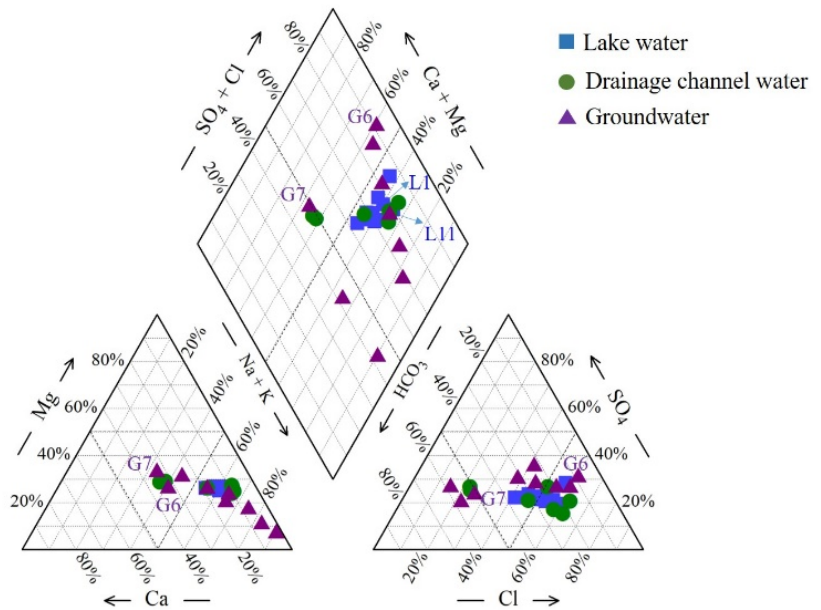
Figure 7. Piper diagram showing the hydrochemical types in the three water bodies.